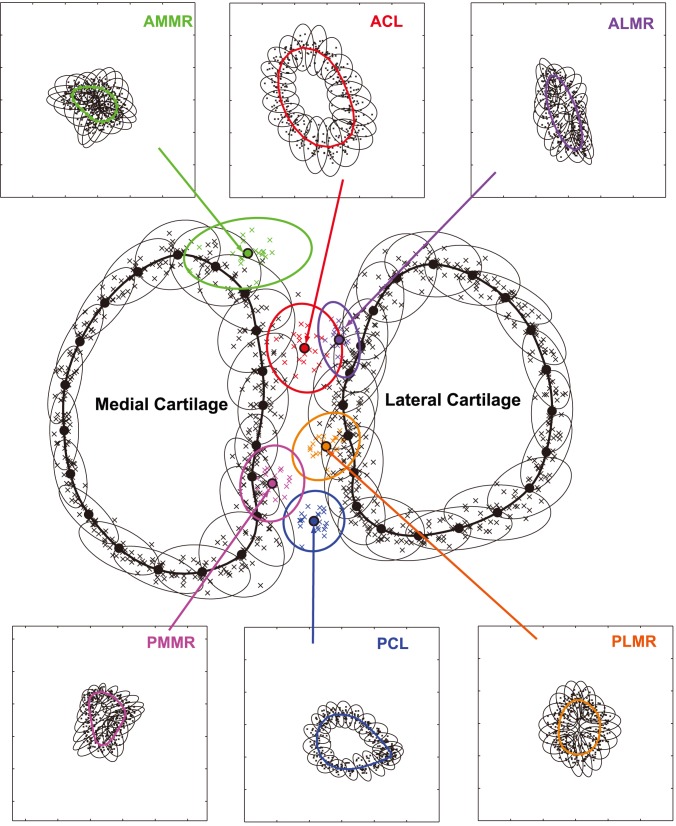
Statistical representations of tibial cartilage, cruciate ligament and meniscus insertion location and shape variability.The thick outlines are the mean or “most representative” shapes (the black thick outlines for tibial cartilage and the colored thick lines in the upper and lower subplots for six insertion sites); the color ellipses are 99% confidence ellipses for the insertion centroid locations resulting from PCA; the thin ellipses centered at the equidistant landmarks (20 on each outline) quantify the landmark position variability individually and the shape variability collectively.